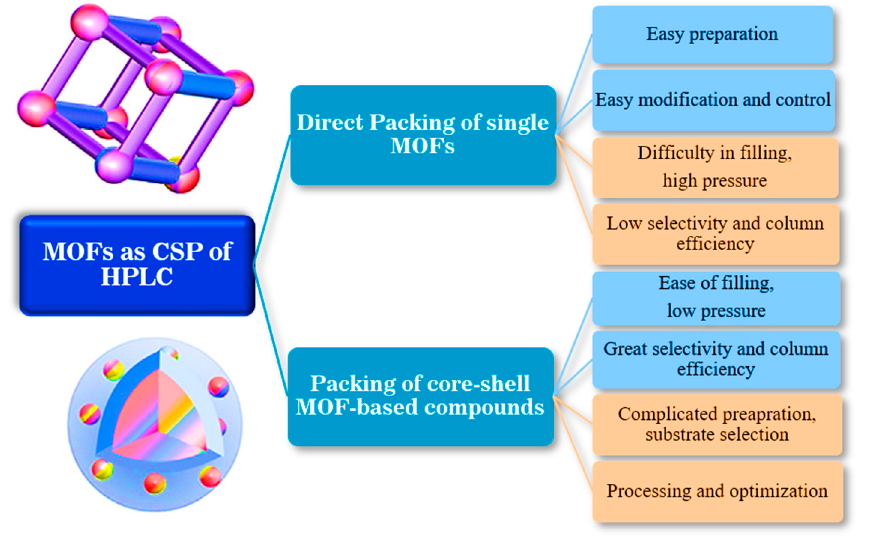
Figure 11. The pulse points and downsides of core-shell MOF and single MOF particle-based composites employed as HPLC columns.